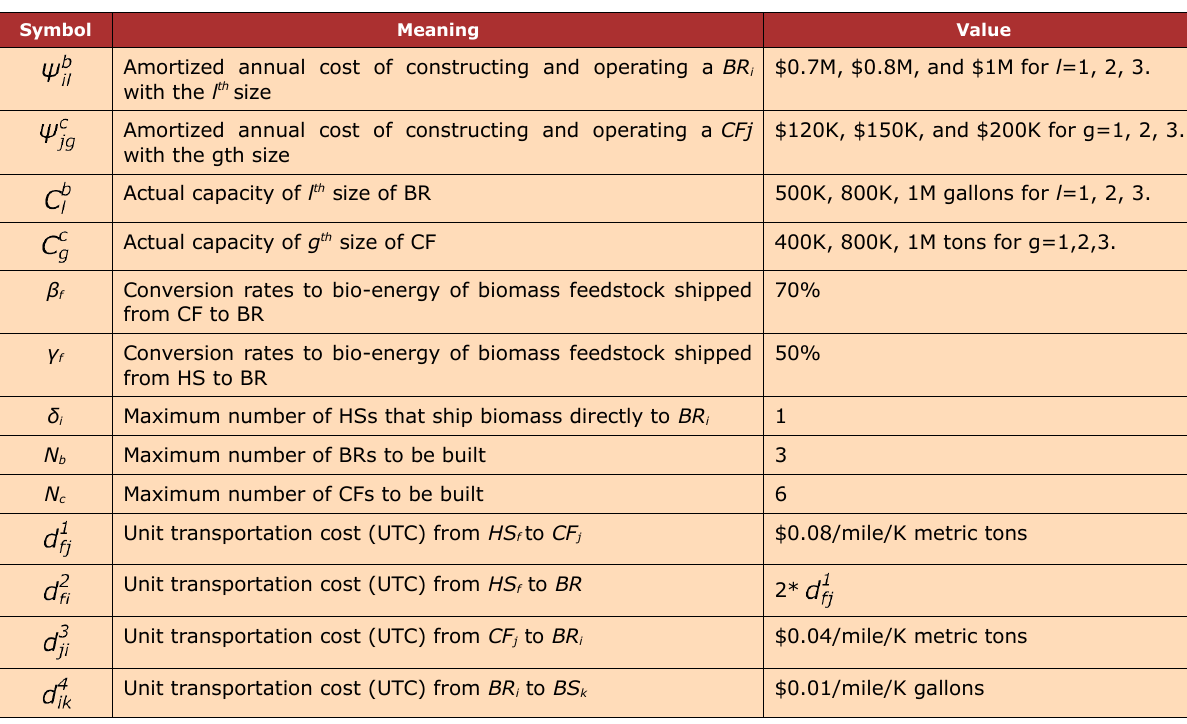
Table 1b. Input Data Used for Case